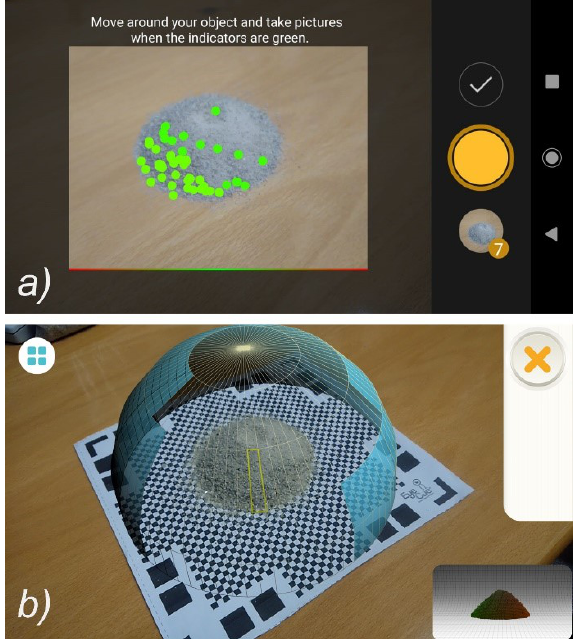
Figure 1. Scann3D (a) and Qlone (b) capturing